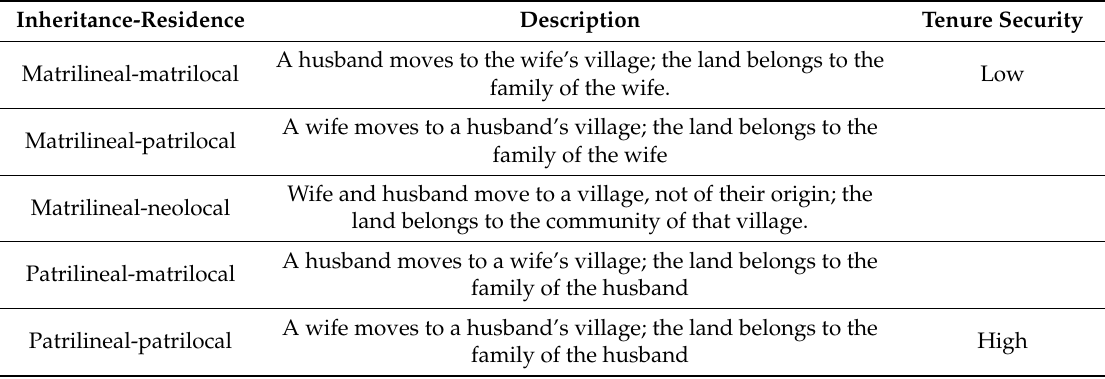
Table 1. Customary-based tenure security ranking of male land use decision